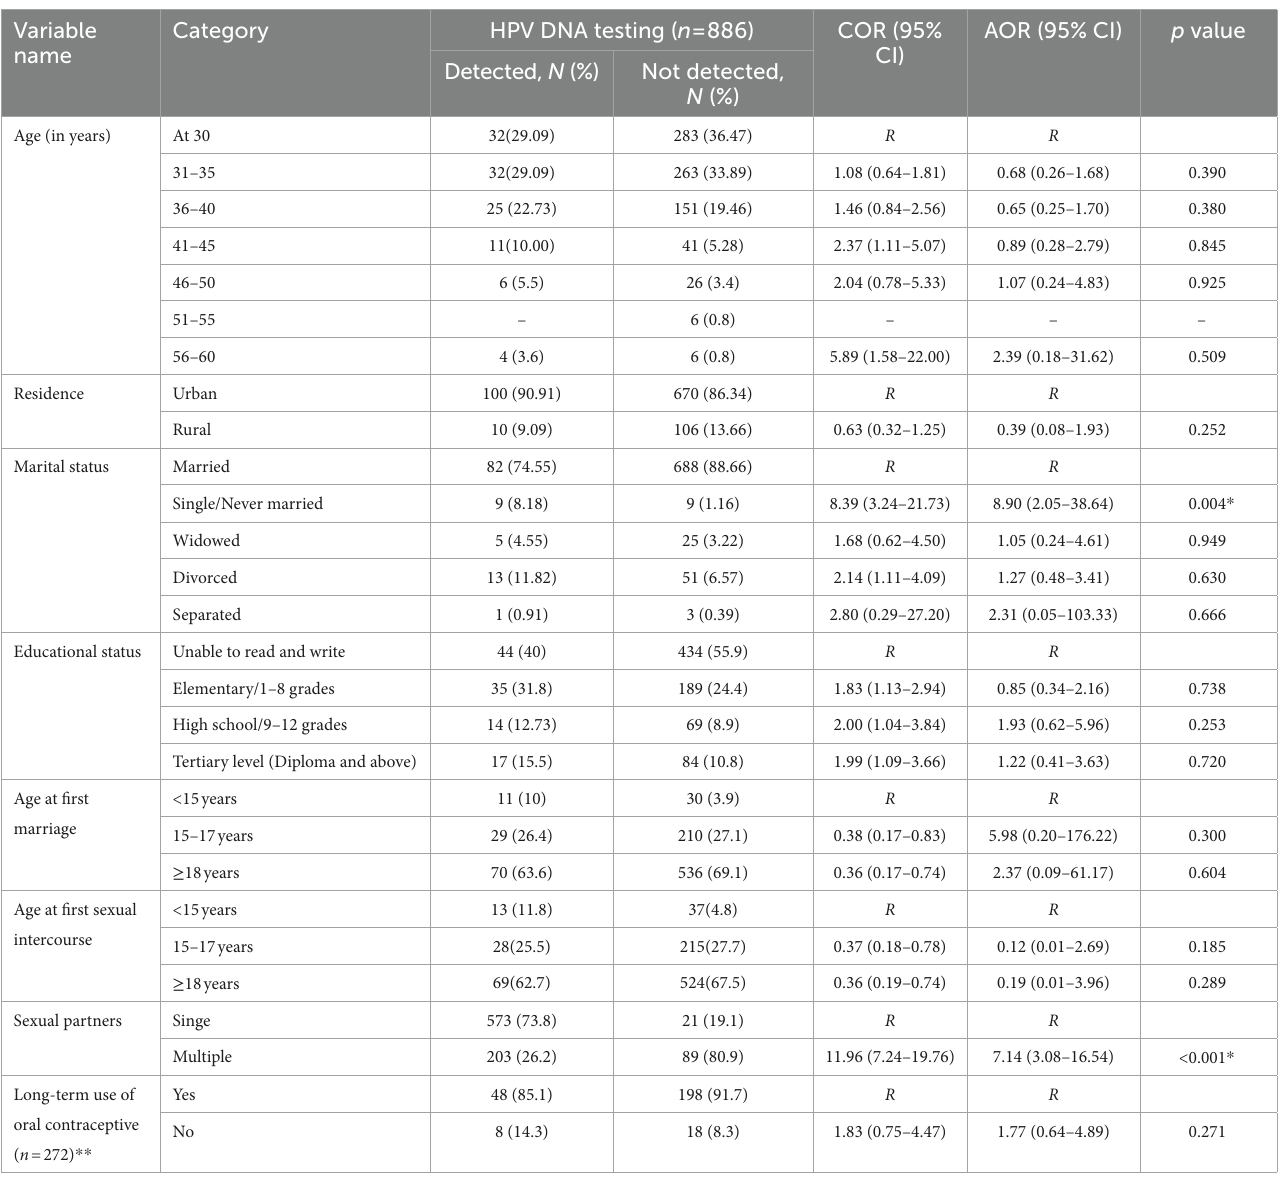
TABLE 4 Shows the associated factors for hr HPV infection on the multivariate logistic regression